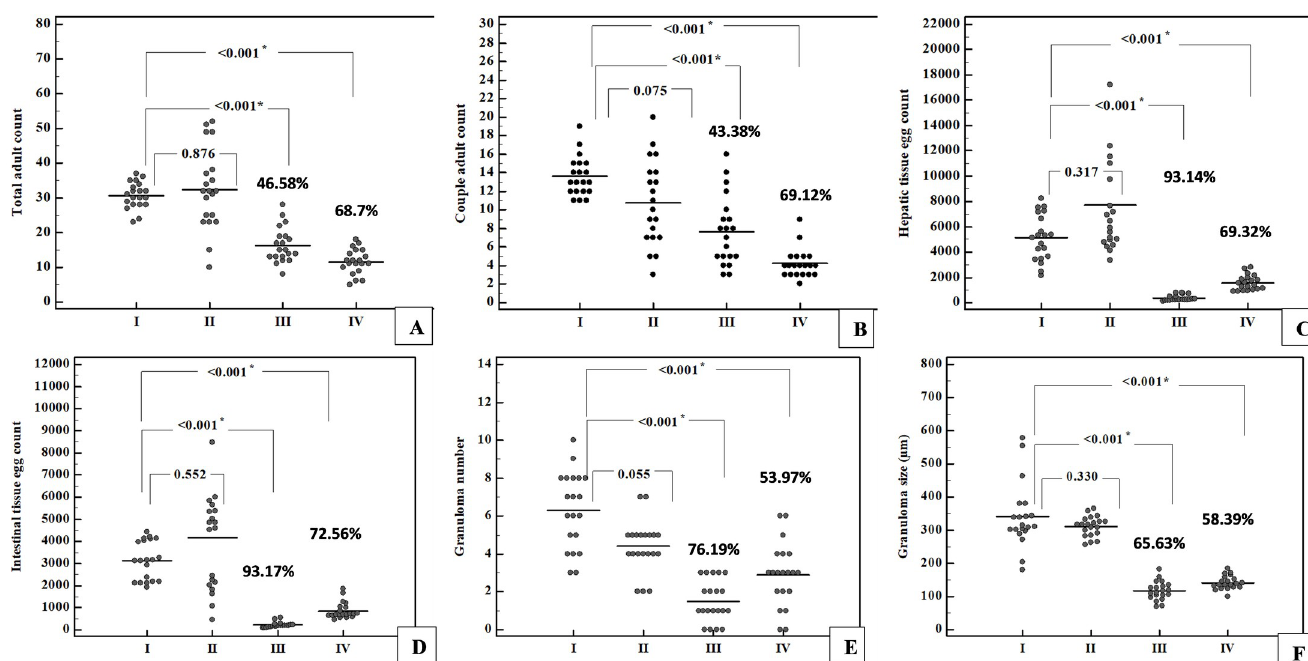
Fig 2. Scatter plot of parasitological evaluation parameters of the studied groups. A : Adult worm load in different studied groups obtained by perfusion technique 6 weeks post infection. B : Couple worm load in the studied groups C : Hepatic tissue egg count in the studied groups. D : Intestinal tissue egg count in the studied groups. E : Granuloma number in the livers of the studied groups. F: Granuloma size in micrometre measured in the livers of the studied groups. %: Represent the percent change. � : Statistically significant at p � 0.05.